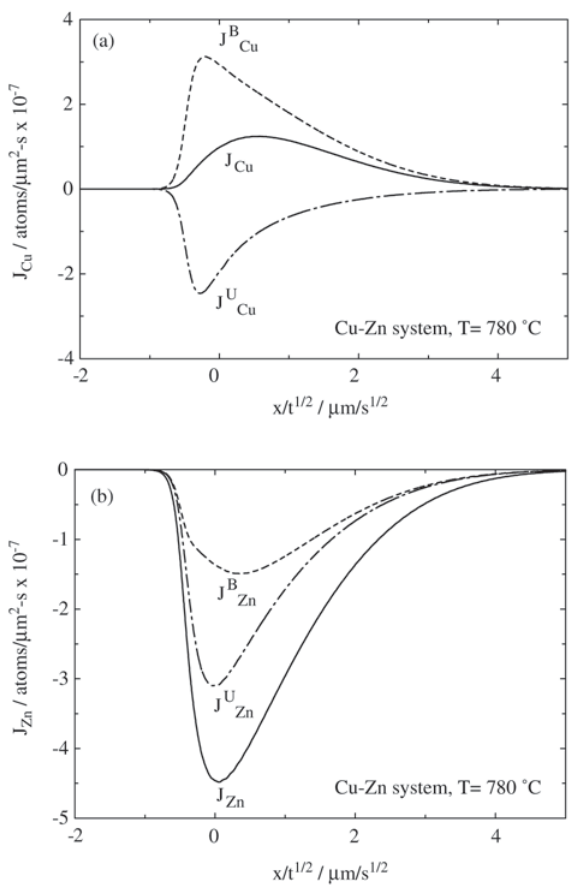
Figure 11. Total, biased and unbiased components of the intrinsic flux for a diffusion couple in the Cu-Zn system 32 . a) Cu; b) Zn.